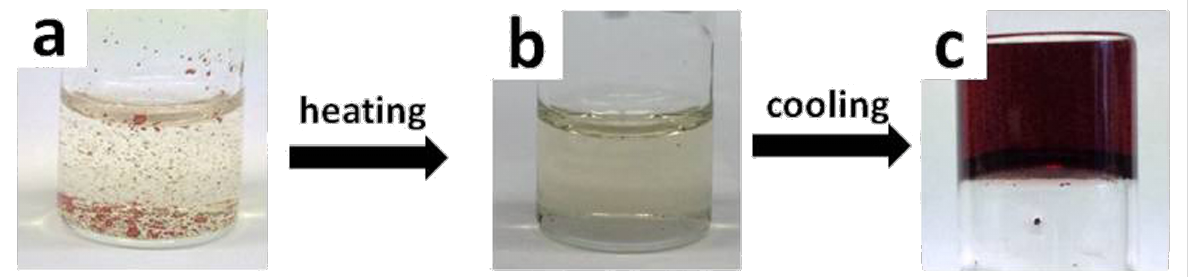
Figure 1: (a) GA-pyrene ( 3 ) and TNF ( 4 , 1:1, molar ratio, [ 3 ] = 12 mM) in DMSO/water (3:1, v/v). The red insoluble solid is undissolved residue of 3 and 4 . (b) A yellow solution was formed upon heating the mixture at 70 °C. (c) Upon cooling to room temperature, gelation could be observed with intensified red colour.